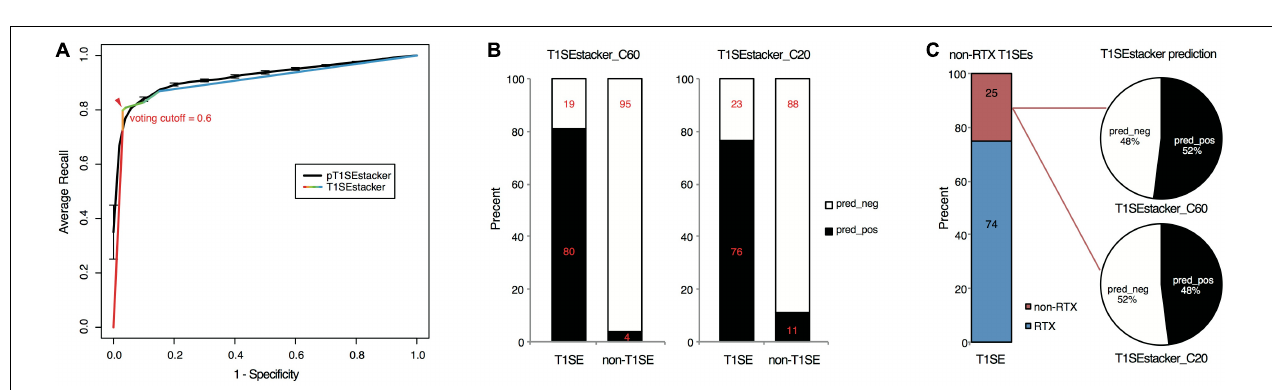
FIGURE 5 | Performance of individual and stacking models on prediction of RTX proteins. (A) Fivefold cross-validation ROC curves of individual machine-learning models predicting RTX and non-RTX proteins based on the C-terminal 20-aa features. (B) Fivefold cross-validation ROC curves of individual machine-learning models predicting RTX and non-RTX proteins based on the C-terminal 60-aa features. (C) Performance comparison of the primary stacking models (pT1SEstacker_C20 and pT1SEstacker_C60) and the representative individual machine-learning models (MM_C20 and MM_C60), based on the average fivefold cross-validation results.